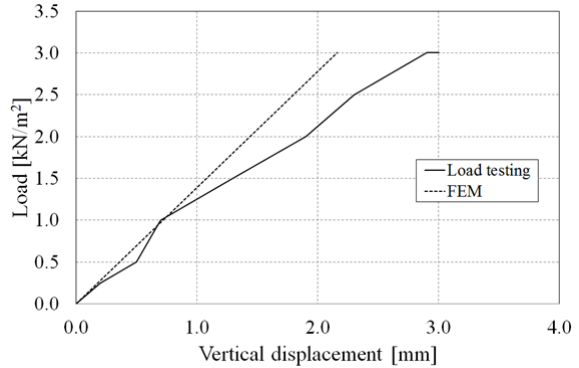
Fig. 14 Comparison of the measured and FEM vertical displacement of the section